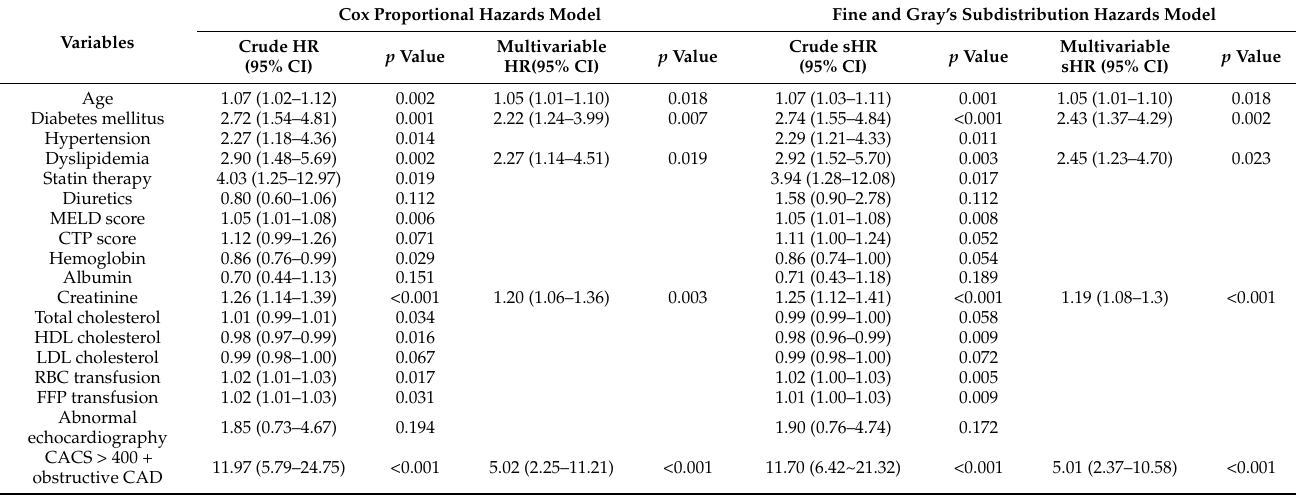
Figure 3. Unadjusted hazard ratio of the CTCA findings for predicting long-term major adverse cardiac events. CACS, coronary artery calcium score; CAD, coronary artery disease; diamond, hazard ratio; horizontal line, 95% confidence interval. Table 5. Cox proportional and the Fine and Gray proportional subdistribution hazards models for major adverse cardiac events within 5 years after living donor liver transplantation.